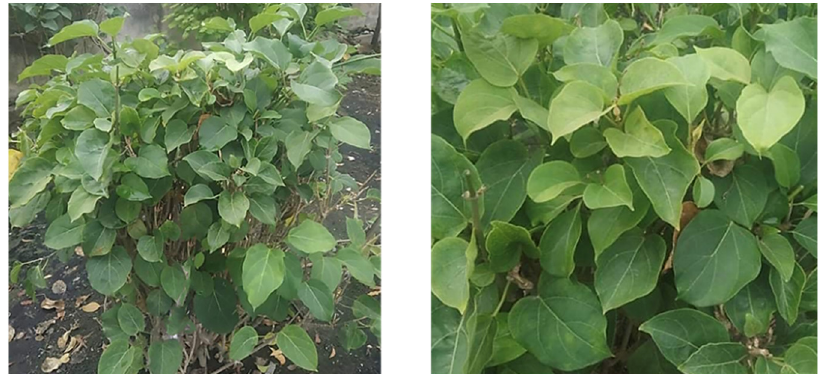
Figure 1. Dregea volubilis .